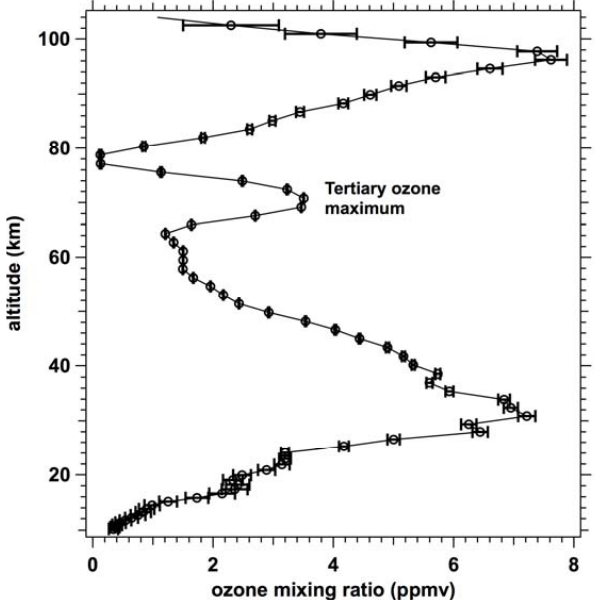
Fig. 28. Vertical profile of ozone mixing ratio measured by GOMOS with star S001 on orbit 4638, at 71° N latitude on January 30, 2003. It displays the Tertiary Ozone Maximum, peaking at 3.6 ppmv on this particular profile. The air density is found in the Level 2 GOMOS product, derived from ECMWF and the MSISE 90 model.